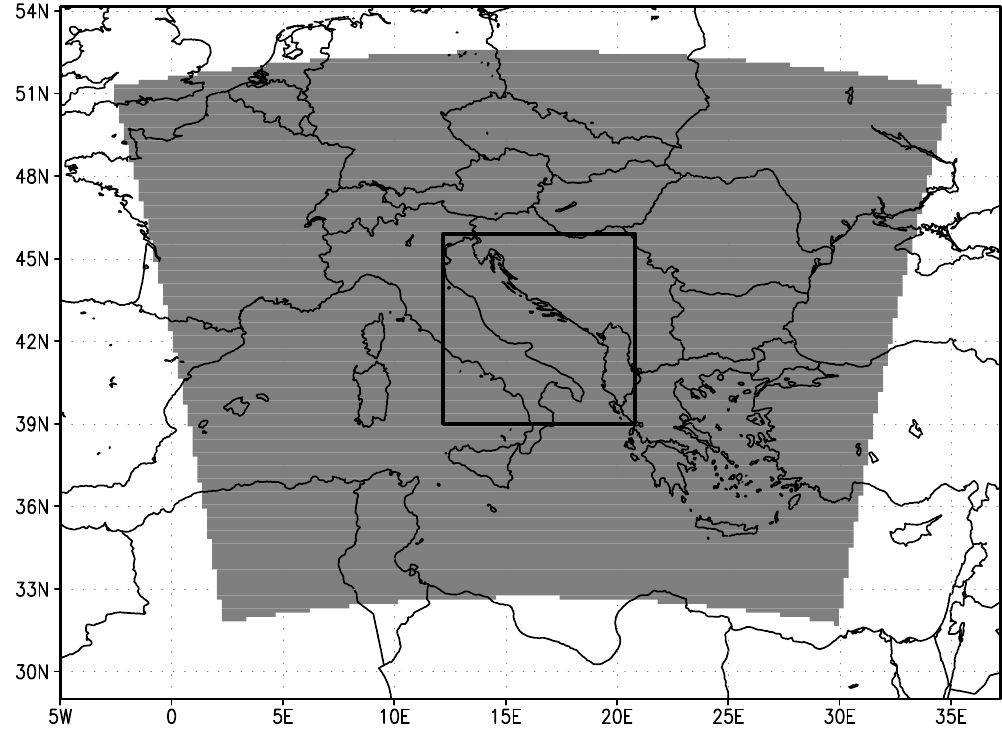
Fig. 1. Overlap of the atmosphere and ocean model domains. The atmosphere domain is in gray, while the ocean domain is the black rectangle at the centre of the picture.